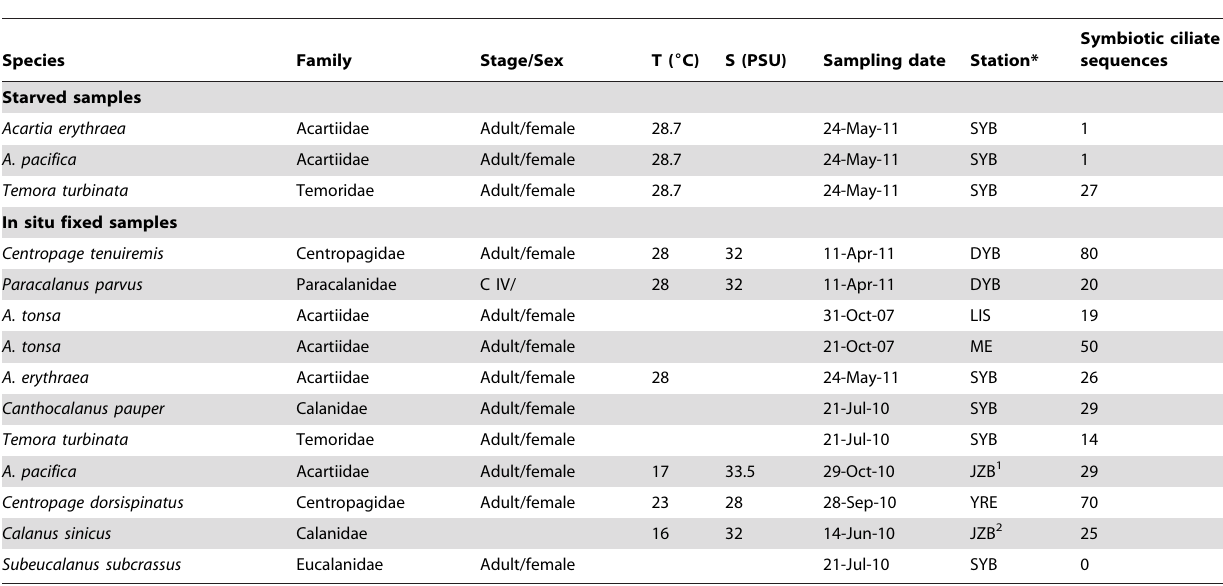
Table 1. Taxonomic and biological information of the copepods and 18S rDNA ciliate sequences number obtained.